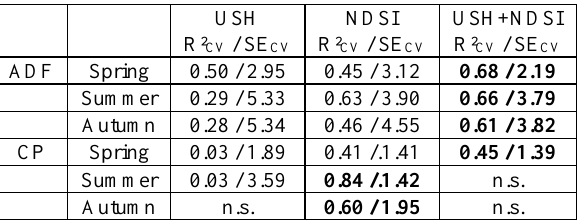
Table 1. Cross-validation results for prediction of ADF and CP in the biomass of heterogeneous pastures from ultrasonic sward height (USH) the normalised difference spectral index (NDSI) exclusively and as a combination of both (USH + NDSI). Values in bold indicate best model approaches (adjusted from Safari et al.,